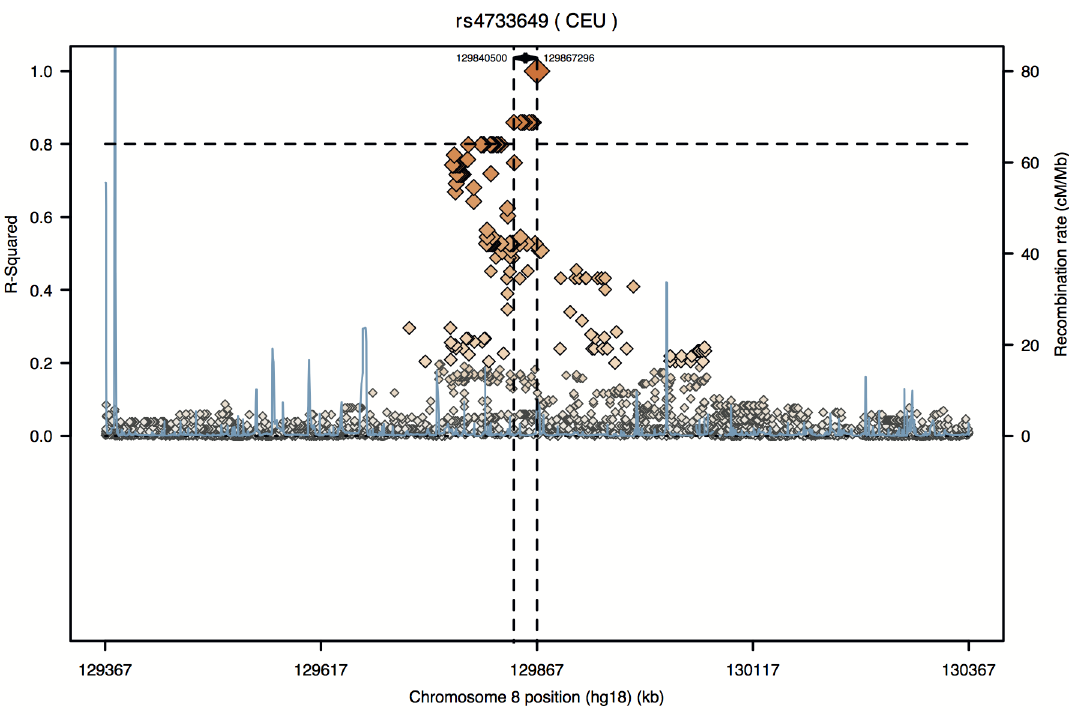
Fig 2. Regional LD plot for rs4733649 at 8q24.21. The pairwise LD (r 2 ) between the SNP of interest and surrounding variants and the estimated recombination rate are plotted as a function of genomic position. This plot was constructed by SNAP (SNP Annotation and Proxy Search, http://www.broadinstitute.org/mpg/snap/ldplot.php) using the CEU population panel in the 1000 Genome Project (1000GP) Pilot 1 data and a 500 kilobases (kb) distance limit on each side. The horizontal dashed line is at the 0.8 cut-off for r 2 , and the vertical dashed lines indicate the genomic region encompassing SNPs in strong LD (r 2 (cid:1) 0.8) with the variant of interest.